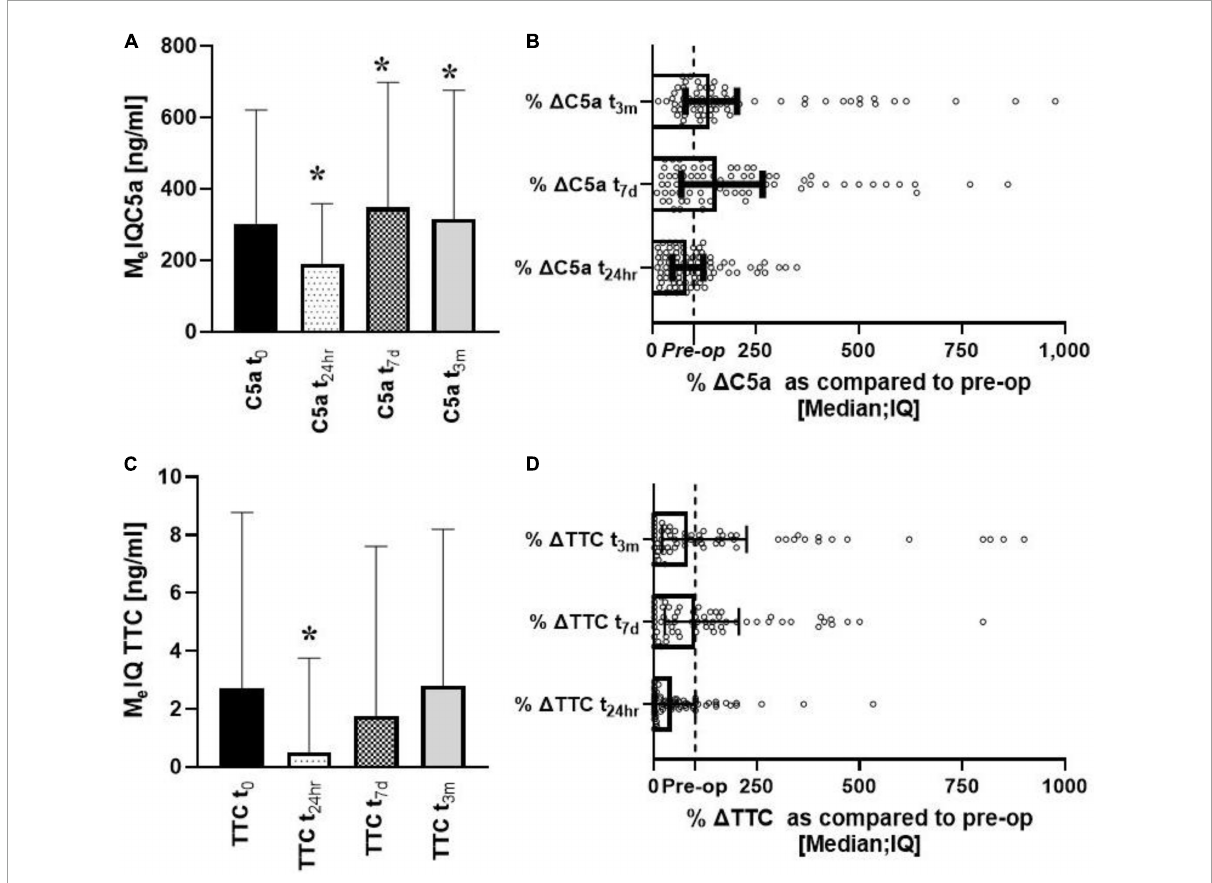
FIGURE1 Longitudinal analysis of complement effectors (sC5a, sTCC) after heart surgery. Serum levels of C5a decreased early after surgery to increase up to 3 months of follow-ups (A,B) . In contrast, sTTC was depressed only at t 24 h (C,D) . *Denotes the statistical significance of 0.05 or